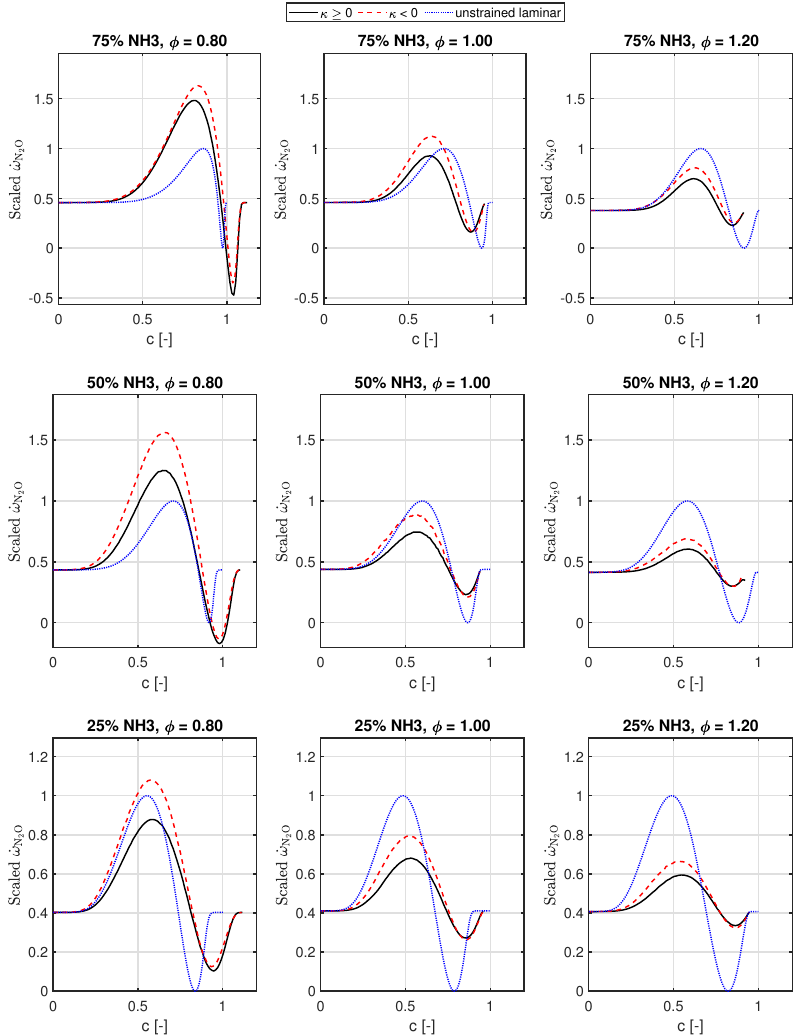
Figure 11. Conditional average of the source term of N 2 O split by positive and negative